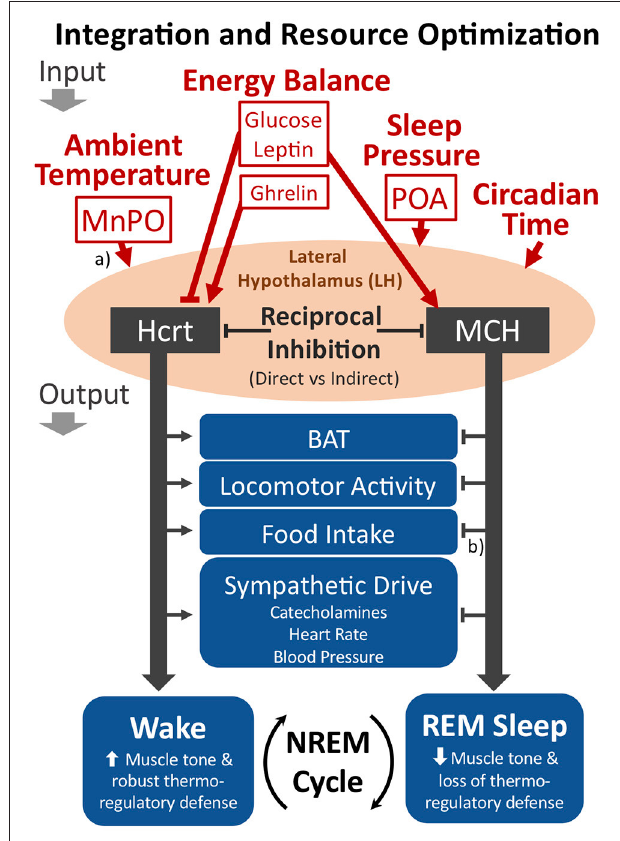
FIGURE 4 | The proposed role of the LH as an integrator of key inputs related to ambient temperature, energy balance, and sleep pressure for the cycling of NREM sleep to either wakefulness or REM sleep. The Hcrt and MCH neuronal systems within the LH show reciprocal firing patterns, suggesting either direct or indirect reciprocal inhibition. If Hcrt activity predominates, the behavioral state of wakefulness is favored, including the promotion of brown adipose tissue (BAT) activation, locomotor activity, food intake, and sympathetic drive. With MCH activity predominating, however, REM sleep is favored. The LH may optimize resource allocations within sleep by modulating the cycling of NREM sleep to either REM sleep or wakefulness (see text). Additional relevant inputs to the LH not depicted in the figure include information pertaining to positive or negative emotional content. (a) The MnPO and POA contain warm sensitive sleep active neurons that may directly innervate the LH. Additionally, the MnPO contains thermosensitive neurons receiving input from the periphery that may also indirectly convey thermoregulatory information to the LH. (b) Although the MCH system appears to have opposing output effects with respect to Hcrt, MCH may either increase or decrease food intake depending on food availability and energy status (see text). Straight arrowheads or bars represent activation or inhibition, respectively. Not shown in the figure are additional cell types within the LH that are involved in behavioral state transitions, such as GABAergic neurons that project to the thalamic reticular nucleus for activation of wakefulness (140). MnPO, median preoptic nucleus; POA, preoptic